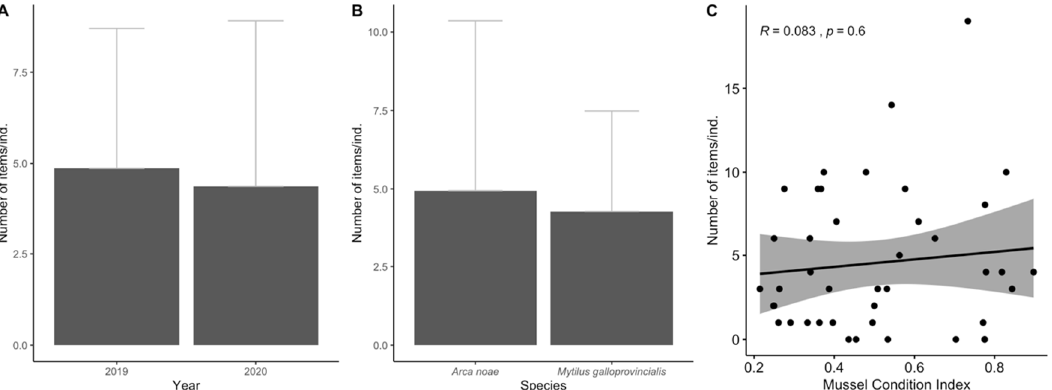
Figure 6. Results for the ingestion of anthropogenic particles (APs) in mollusc samples for: year ( A ), species ( B ) as well as the Spearman’s rank correlation (significance level at p < 0.05) between Mussel Condition Index and number of APs ingestion ( C ). Error bars for indicate a 95% confidence interval and significant differences are indicated by different letters. The significance level was established at p < 0.05.